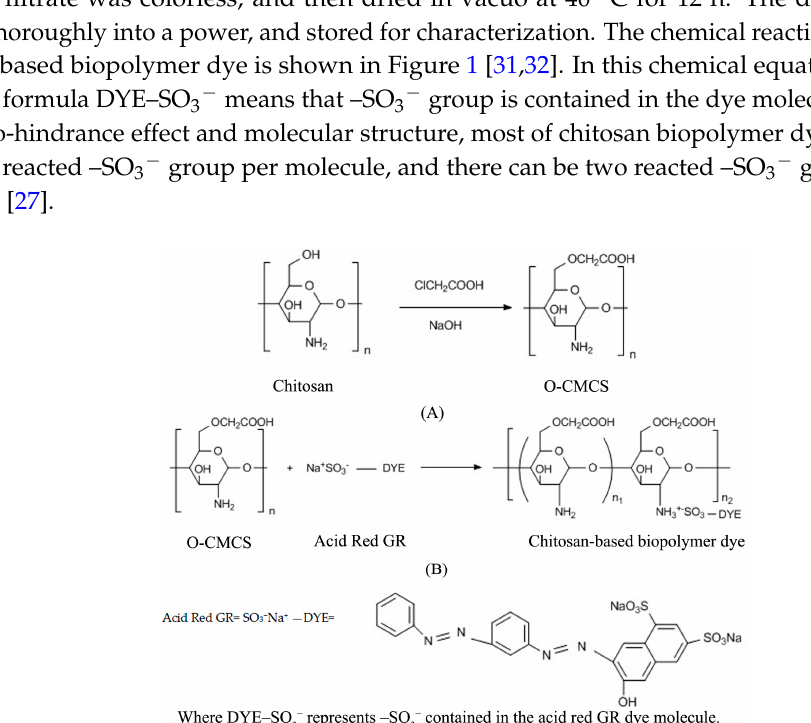
Figure 1. Chemical reaction equations of ( A ) O -CMCS and ( B ) chitosan-based biopolymer dye.